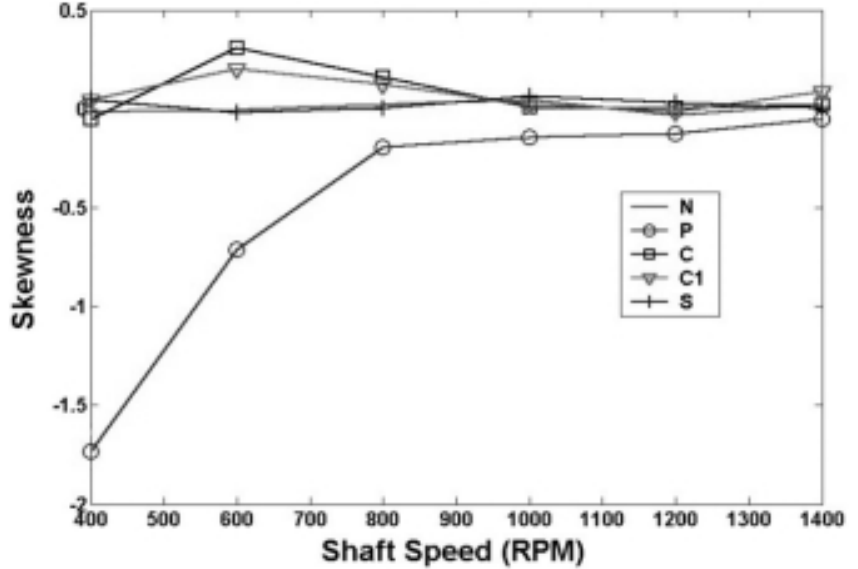
Fig. 1. Skewness of the acceleration signal as a function of the rotating shaft speed, load 3.